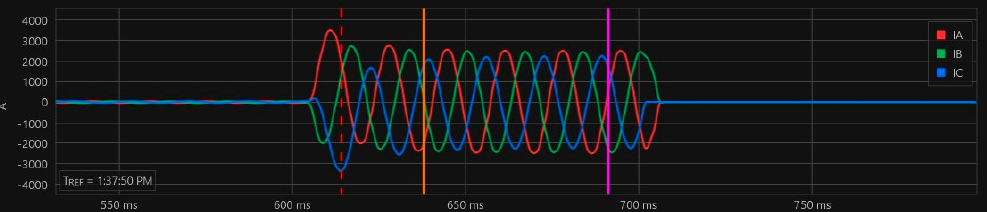
Figure 36. Event obtained for phase currents recorded by R2 under IDMT scheme.